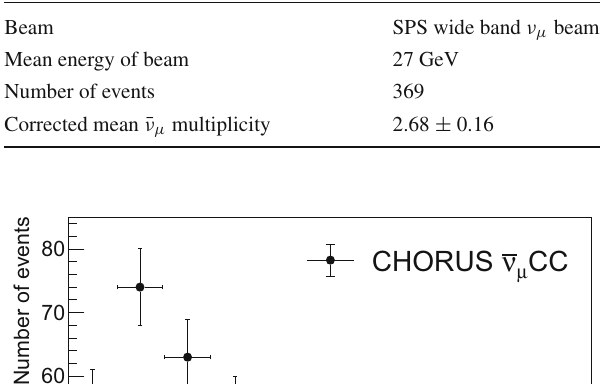
Table 1 Data and features of CHORUS